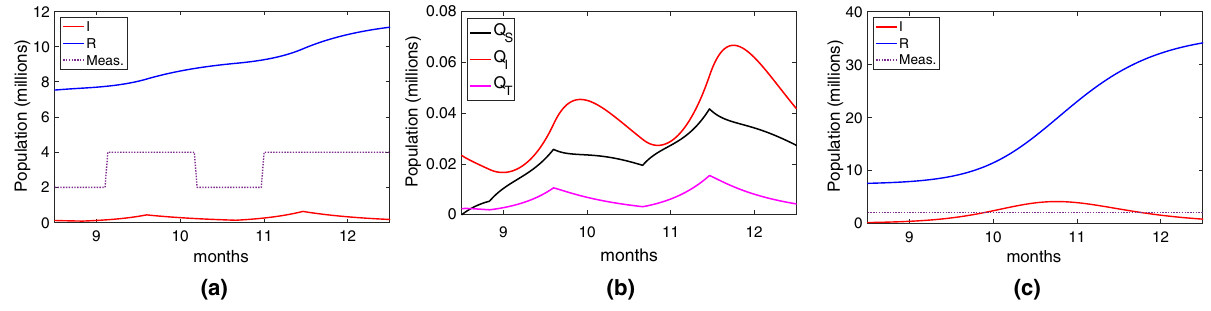
Figure 4. Effectiveness of England’s NHS contact tracing App based on Google/Apple API between September to December 2020. In these figures, the susceptible individuals are not plotted. ( a ) Infected and recovered individuals under the real scenario; ( b ) People quarantined; ( c ) Infected and recovered individuals with no stringent measures taken.